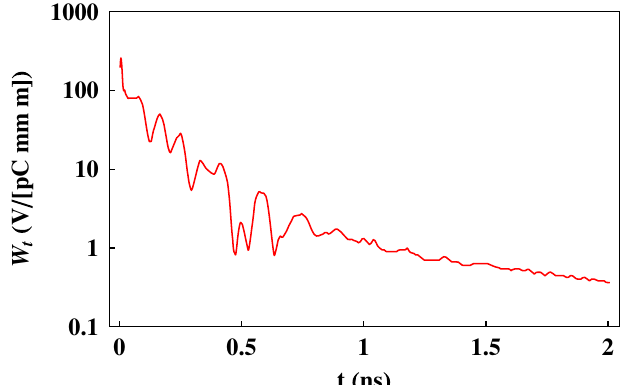
FIG. 3. (Color) Envelope of transverse wakefield for CLIC_G accelerating structure